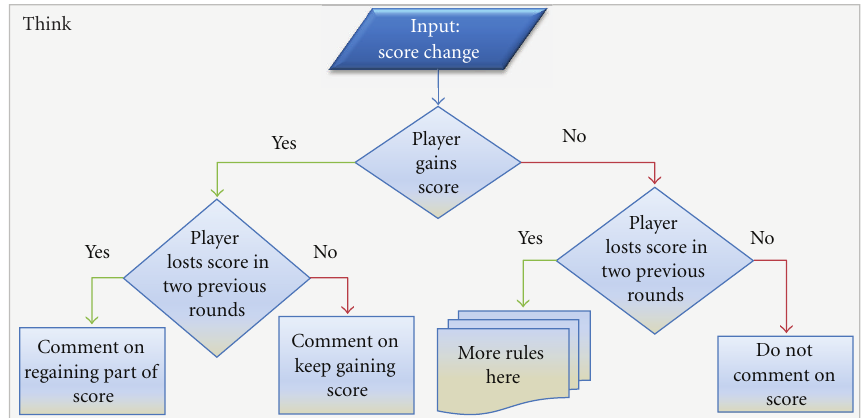
Figure 8: Example of a decision rule diagram used in the think state. The output decision suggests that a comment action should be made about “regaining part of score.” The latter will be fed to the adaptation rules for further processing.